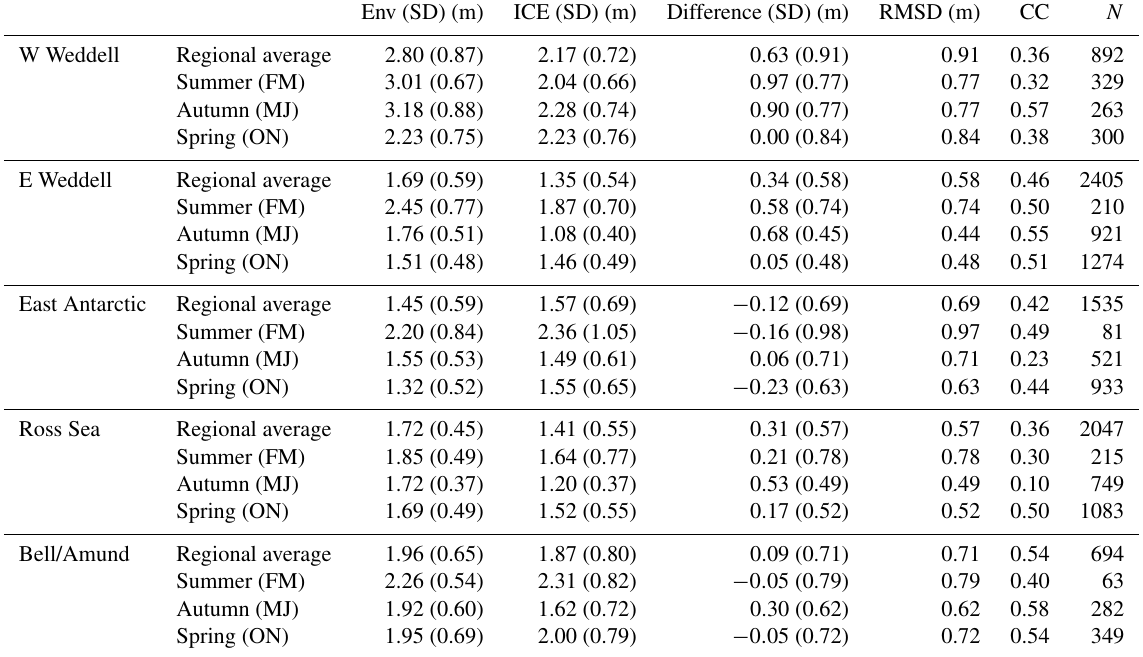
Table 6. Statistical results of the comparisons between Envisat sea ice thickness and ICESat sea ice thickness for each region divided as in Fig. 9. N is the numbers of comparison pairs, taking into account the actual number of values per season. Bell/Amund denotes the Bellingshausen and Amundsen